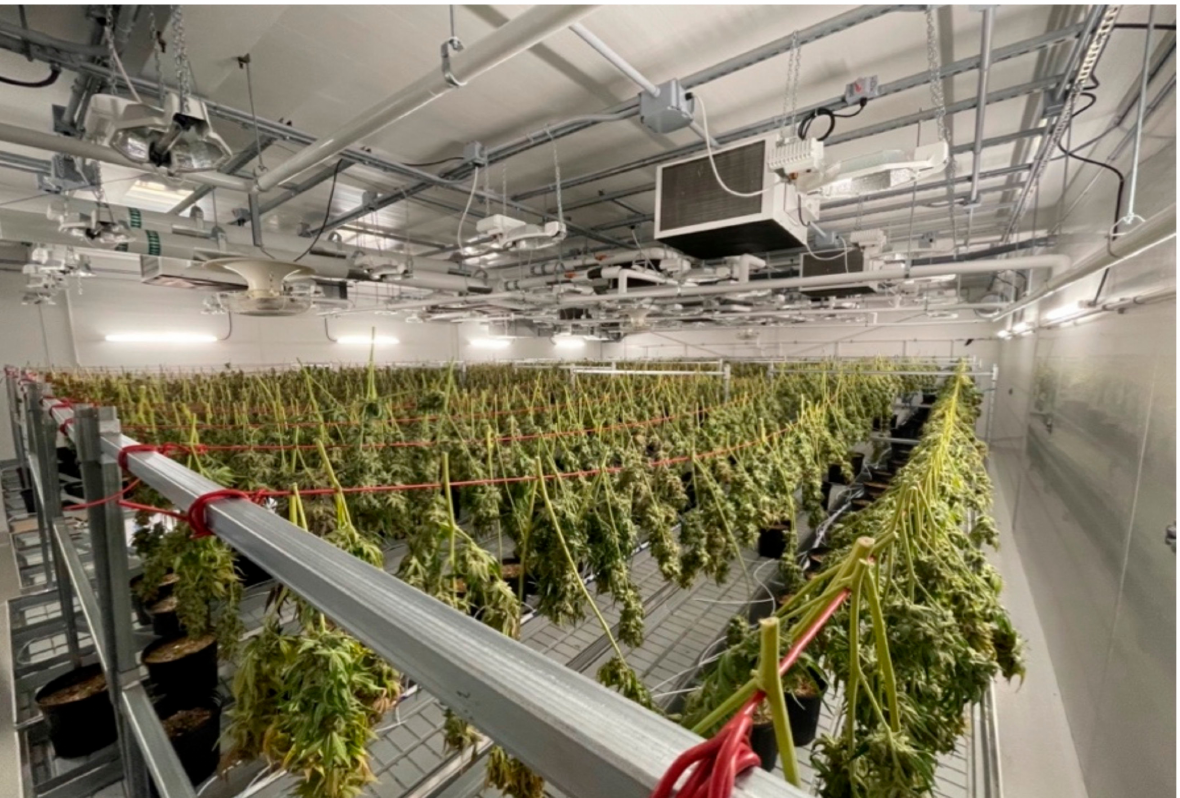
Figure 4. Hang-drying practice commonly used in large scale cannabis operations. Image taken by A. Vista